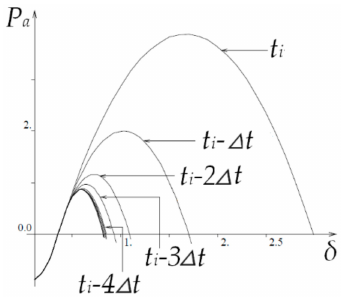
Figure 1. Refreshing transformed one machine infinite bus (OMIB) system’s P a - δ curves.